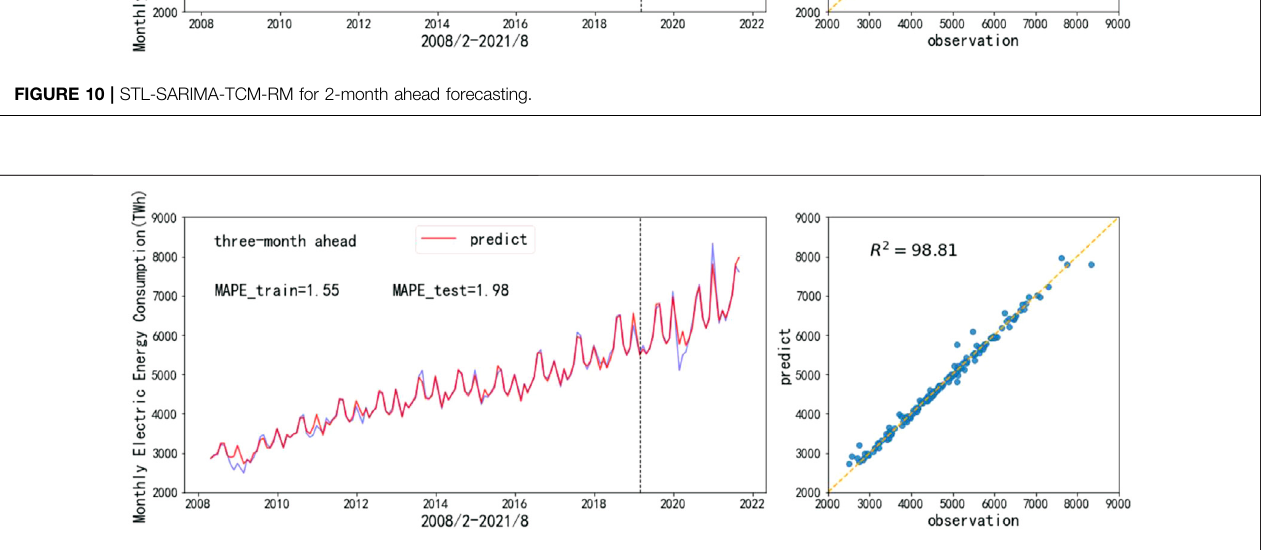
FIGURE 11 | STL-SARIMA-TCM-RM for 3-month ahead forecasting.